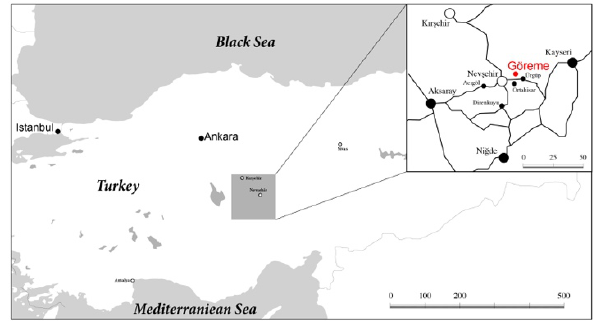
Figure 1. Map of Göreme, Cappadocia and